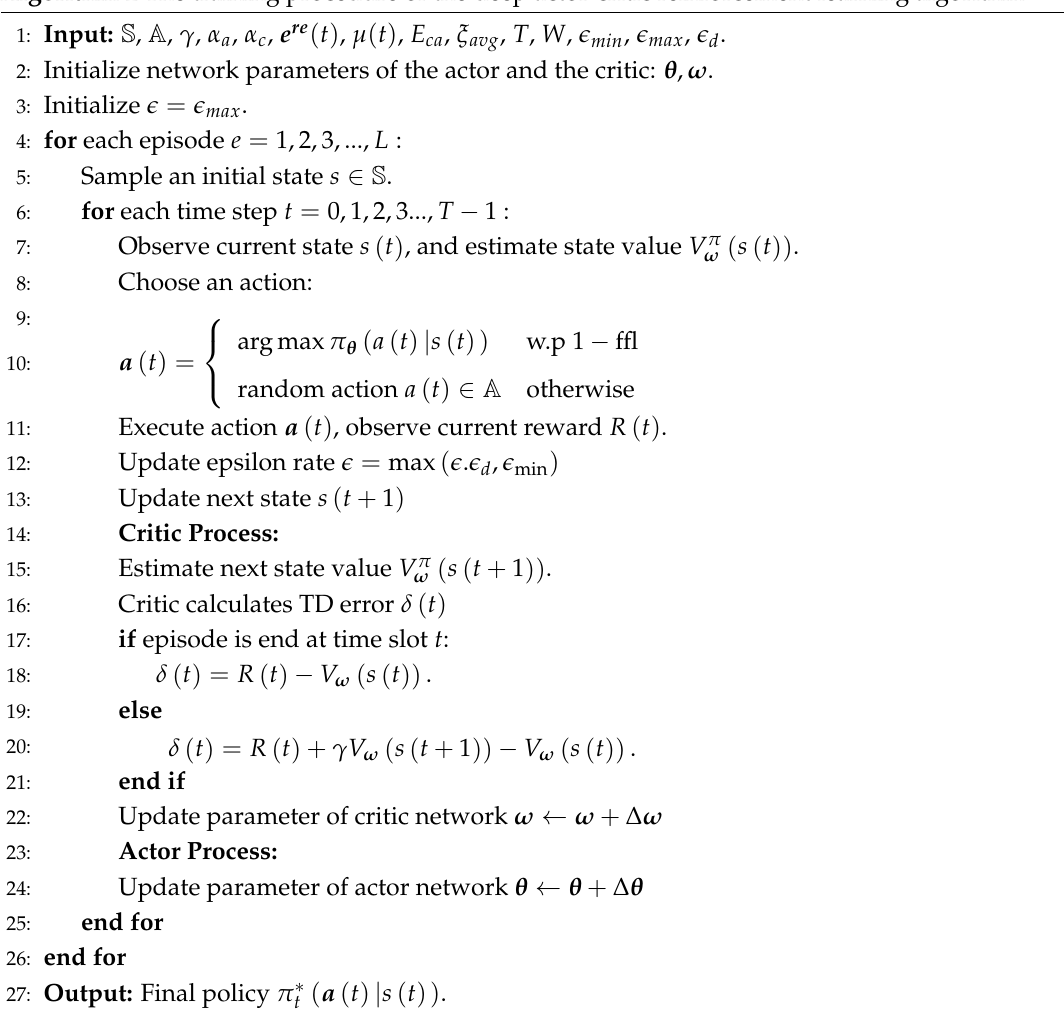
Algorithm 2 The training procedure of the deep actor-critic reinforcement learning